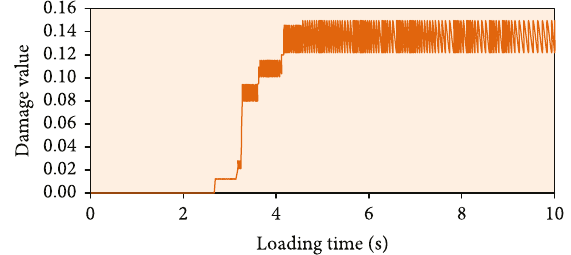
Figure 14: Damage time-interval curve at dam top.